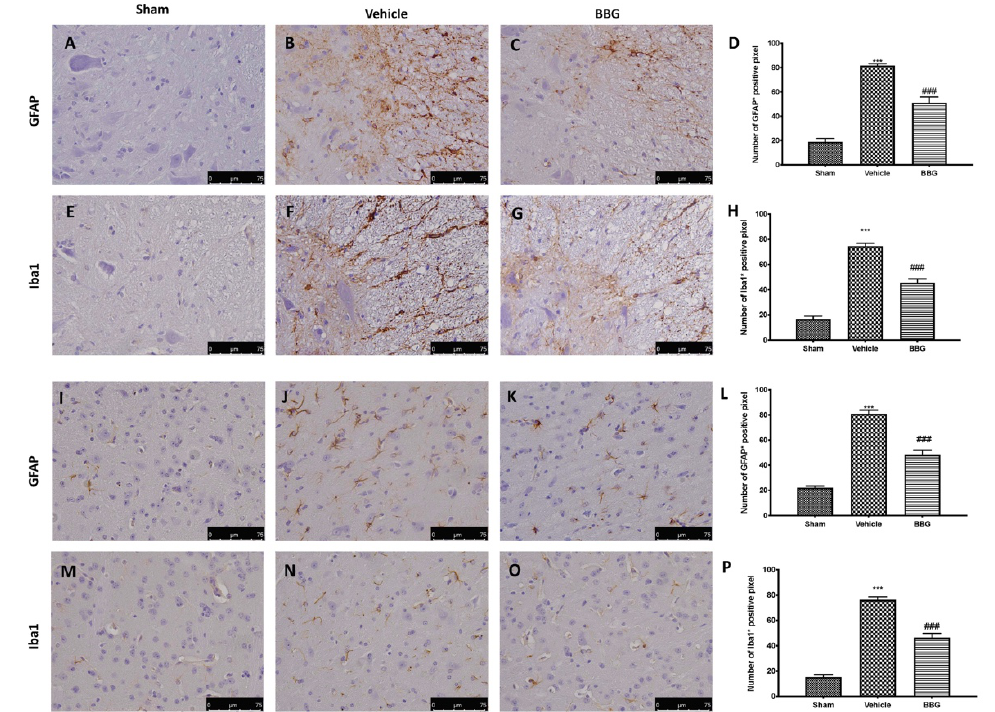
Figure 2. Immunohistochemical evaluation in spinal cord for GFAP expression: Sham ( A ), Vehicle ( B ), BBG ( C ) and Iba1 expression: Sham ( E ), Vehicle ( F ), BBG ( G ). Graphical quantification of GFAP ( D ) and Iba1 expression ( H ) in spinal cord. Immunohistochemical evaluation in hypothalamus region for GFAP expression: Sham ( I ), Vehicle ( J ), BBG ( K ) and Iba1 expression: Sham ( M ), Vehicle ( N ), BBG ( O ). Graphical quantification of GFAP ( L ) and Iba1 expression ( P ) in hypothalamus region. Data are representative of at least three independent experiments and are expressed as mean ± SEM from N = 6 rats/group. *** p < 0.001 vs. sham; ### p < 0.001 vs. vehicle.